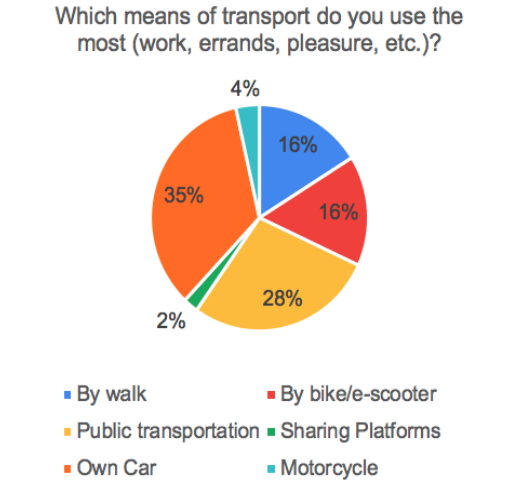
Fig. 1. Actual trend of mobility distribution in Italy, data generated from the survey (686 answers).